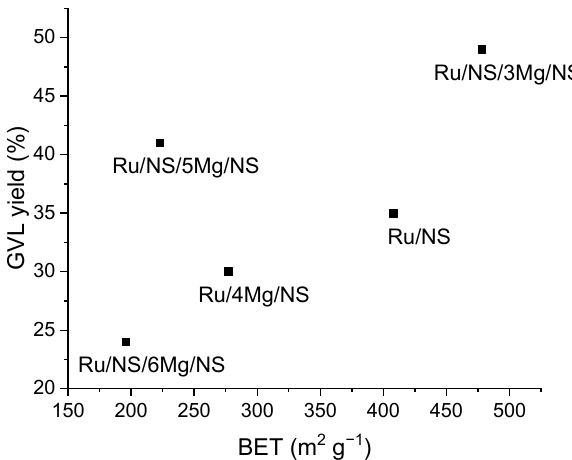
Figure 6. The relation between BET surface area of the catalyst and its yield to GVL. To investigate the potential promoting effect of MgO dopant on the catalytic perfor- mance, the catalyst without magnesium (Ru/NS) was tested in the hydrogenation reaction (Table 4). Slightly lower content of ruthenium in Ru/NS (0.26 wt.%) in comparison to that in Ru/NS/3Mg/NS (0.32 wt.% of Ru) could have an impact on the lower conversion. On the other hand, the sample with slightly higher content of ruthenium and greater loading of magnesium, i.e., Ru/NS/5Mg/NS (0.35 wt.% of Ru), was less efficient in the reaction than Ru/NS/3Mg/NS. The same trend in activity was observed in 2-propanol decomposition (Figure 5). From among the catalysts doped with magnesium, the optimal loading with magnesium was found to be 3 wt.%. For this value of magnesium loading the modification with silica seems to be the most